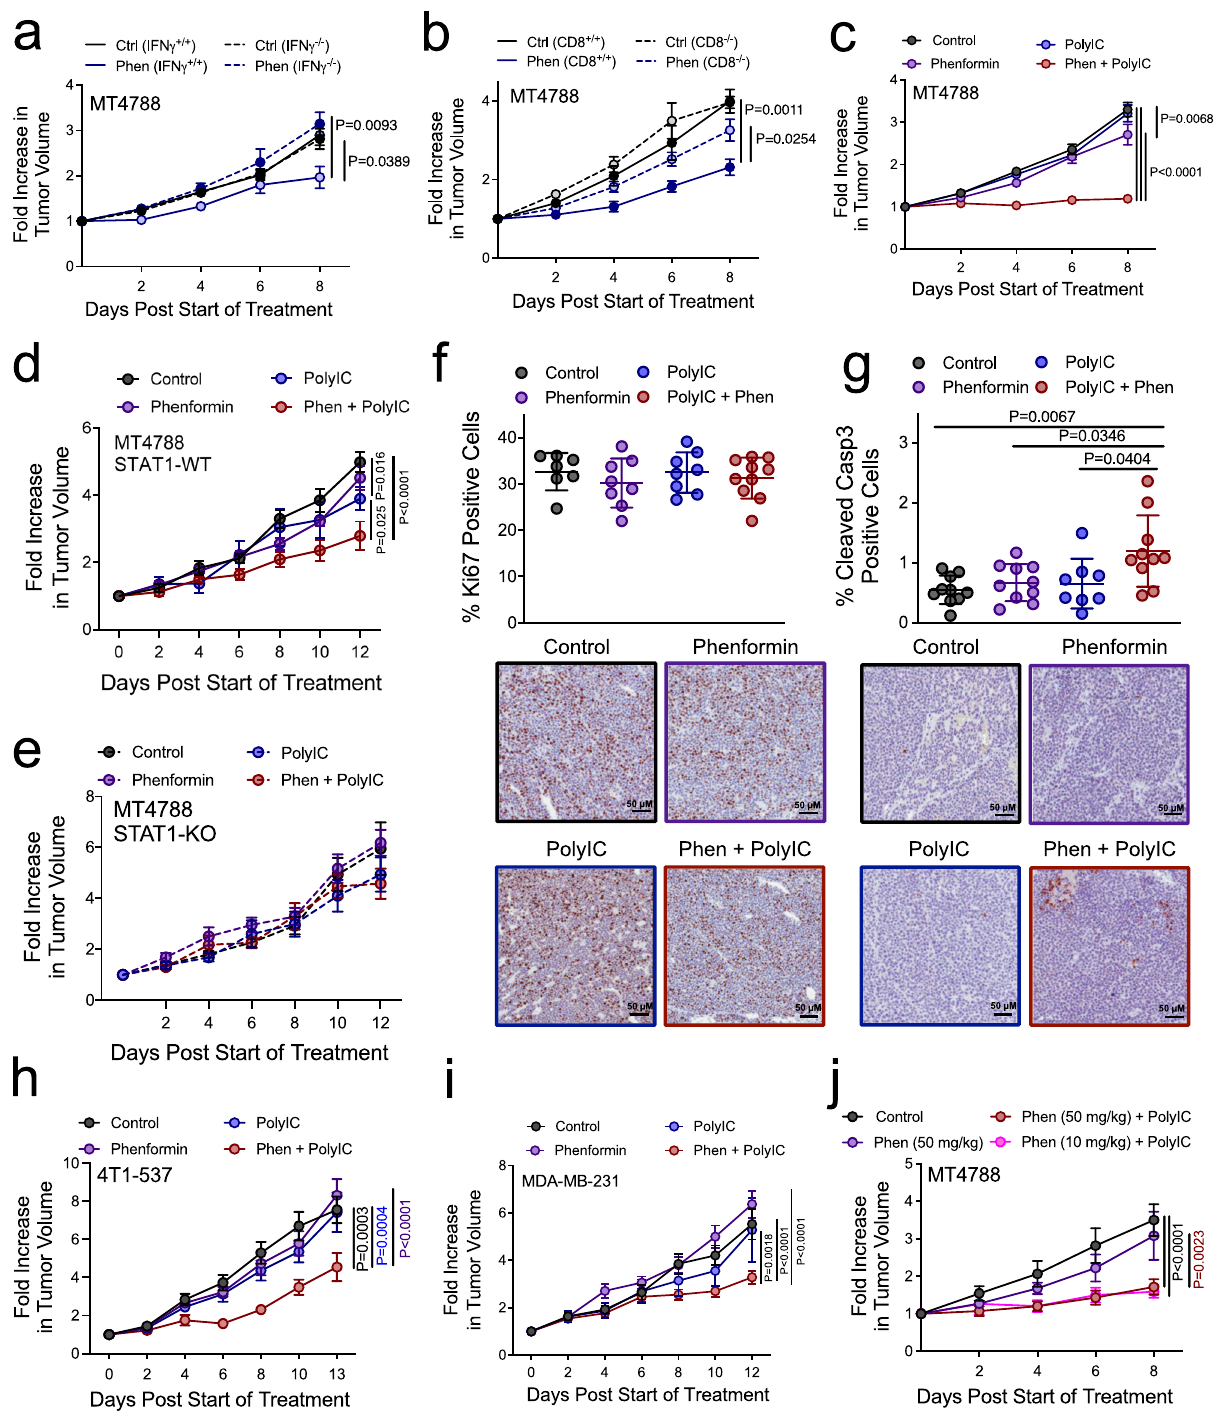
tumors (Fig. 2c). Moreover, polyIC enhanced the tumoricidal properties of phenformin against STAT1-wild-type (WT) (Fig. 2d), but not STAT1-de fi cient (Fig. 2e), tumors. This suggests that the ability of polyIC to sensitize breast cancers to the tumoricidal effects of phenformin requires an intact STAT1 pathway. Immunohistochemical (IHC) analysis con fi rmed increased STAT1 levels in polyIC-treated tumors (Supplementary Figure 2c), whereas phenformin-treated tumors showed elevated phospho-AMPK levels (Supplementary Figure 2d). We observed no signi fi cant changes in Ki67 staining between control and treatment groups (Fig. 2f). However, polyIC and phenformin,